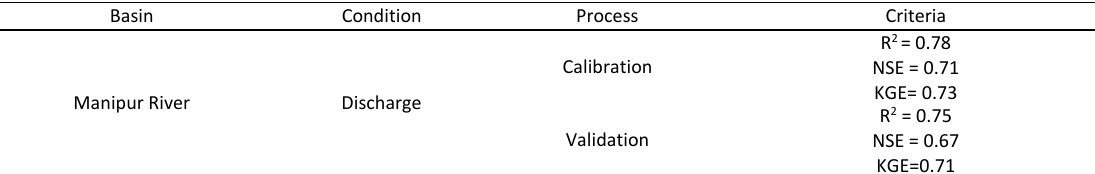
Table 5: Statistical measures of SWAT model parameters Basin